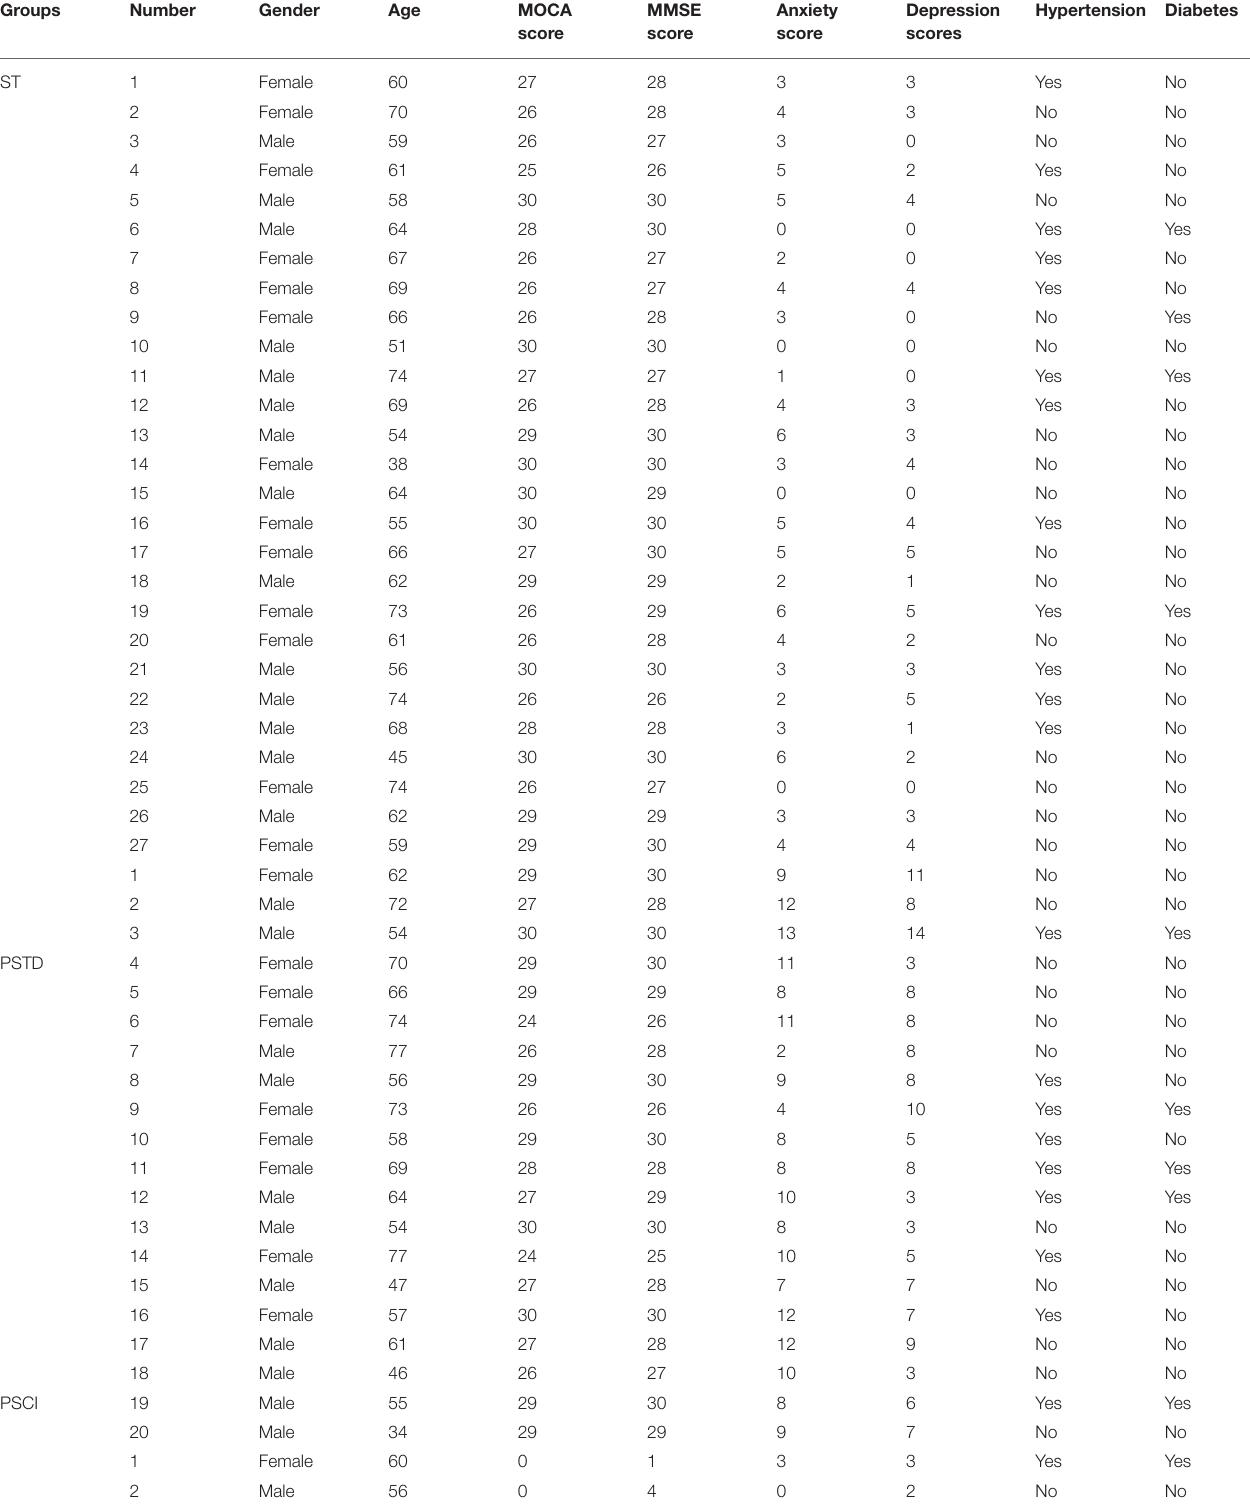
TABLE 1 | Clinical information of enrolled patients.